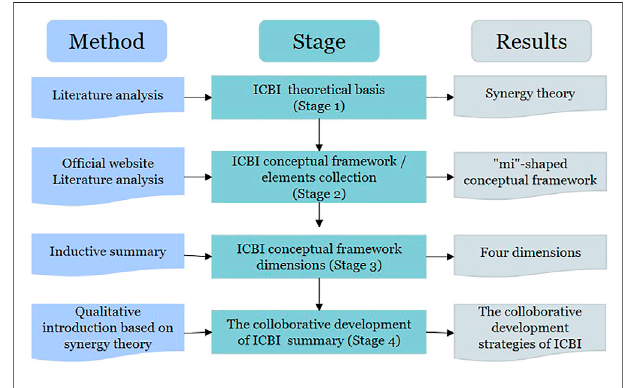
FIGURE 1 | Research fl owchart. FIGURE 2 | Stakeholders ’ Collaboration in the collaborative